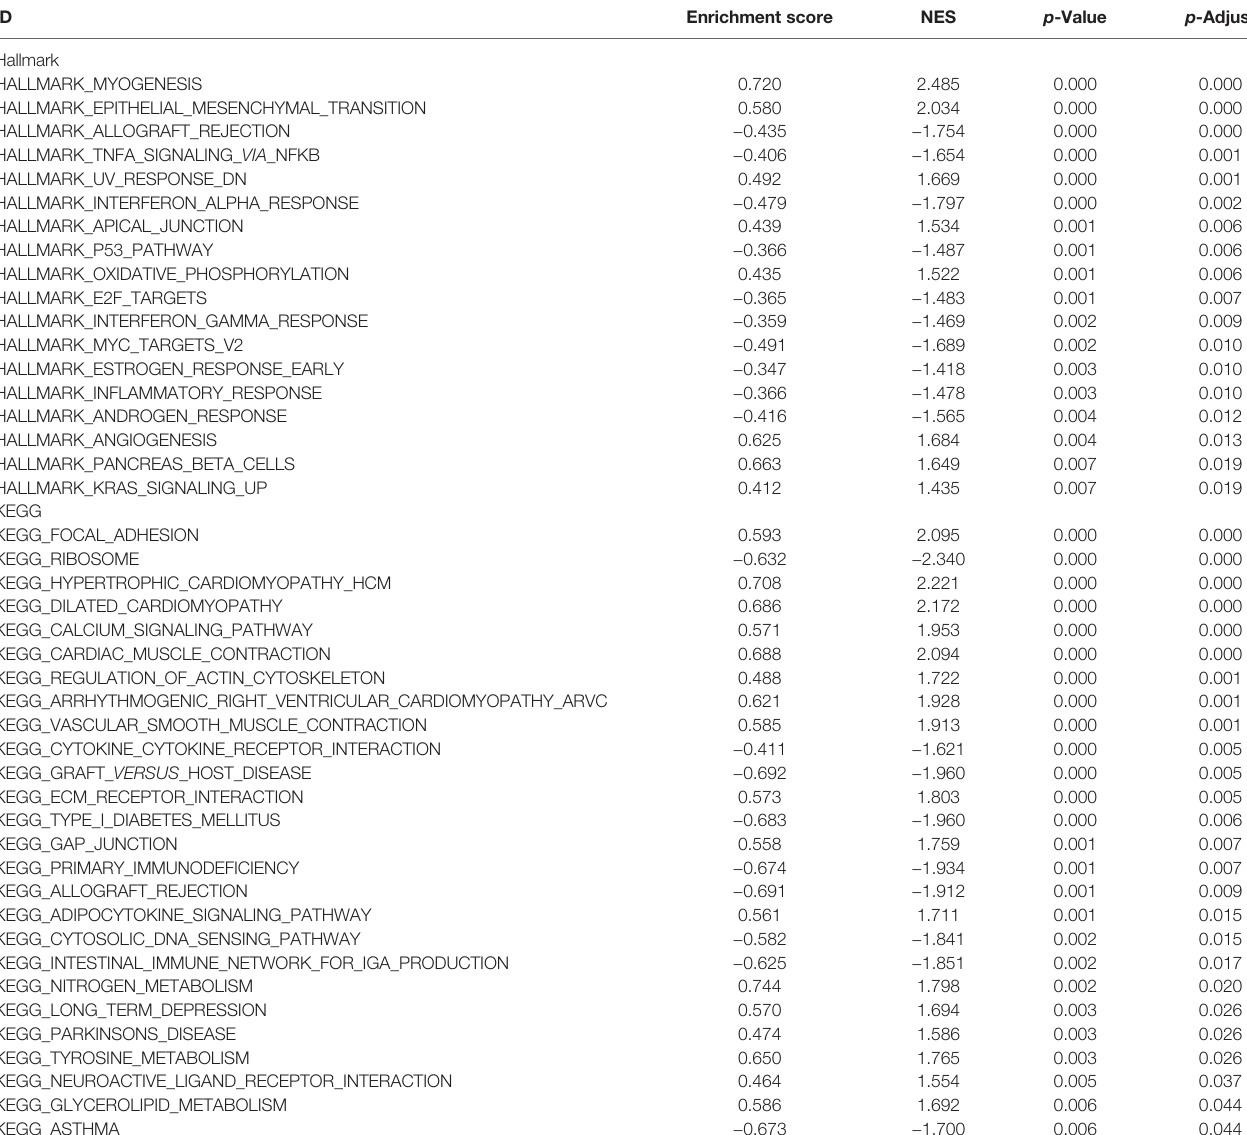
TABLE 3 | GSEA for high- and low-risk groups based on 10-gene signature. ID Enrichment score NES p -Value p -Adjust Hallmark